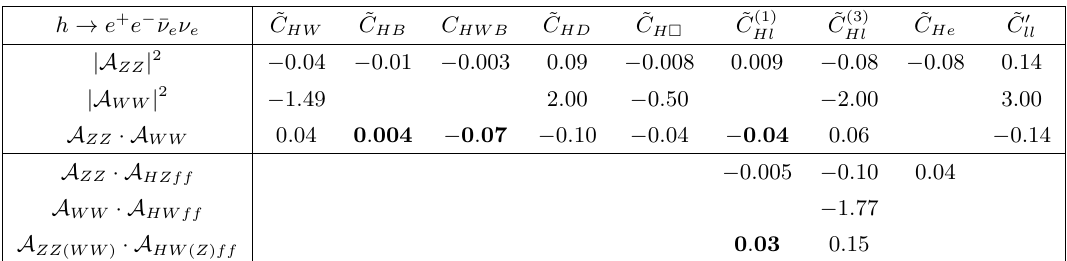
Table 3 . Contribution to a ( ee(cid:23)(cid:23) ) from di(cid:11)erent interference terms. First block: ZZ and WW i mediated diagrams. Second block: diagrams involving contact operators. Corrections to the W; Z propagators are omitted in this table. The most signi(cid:12)cant contributions are highlighted in bold.